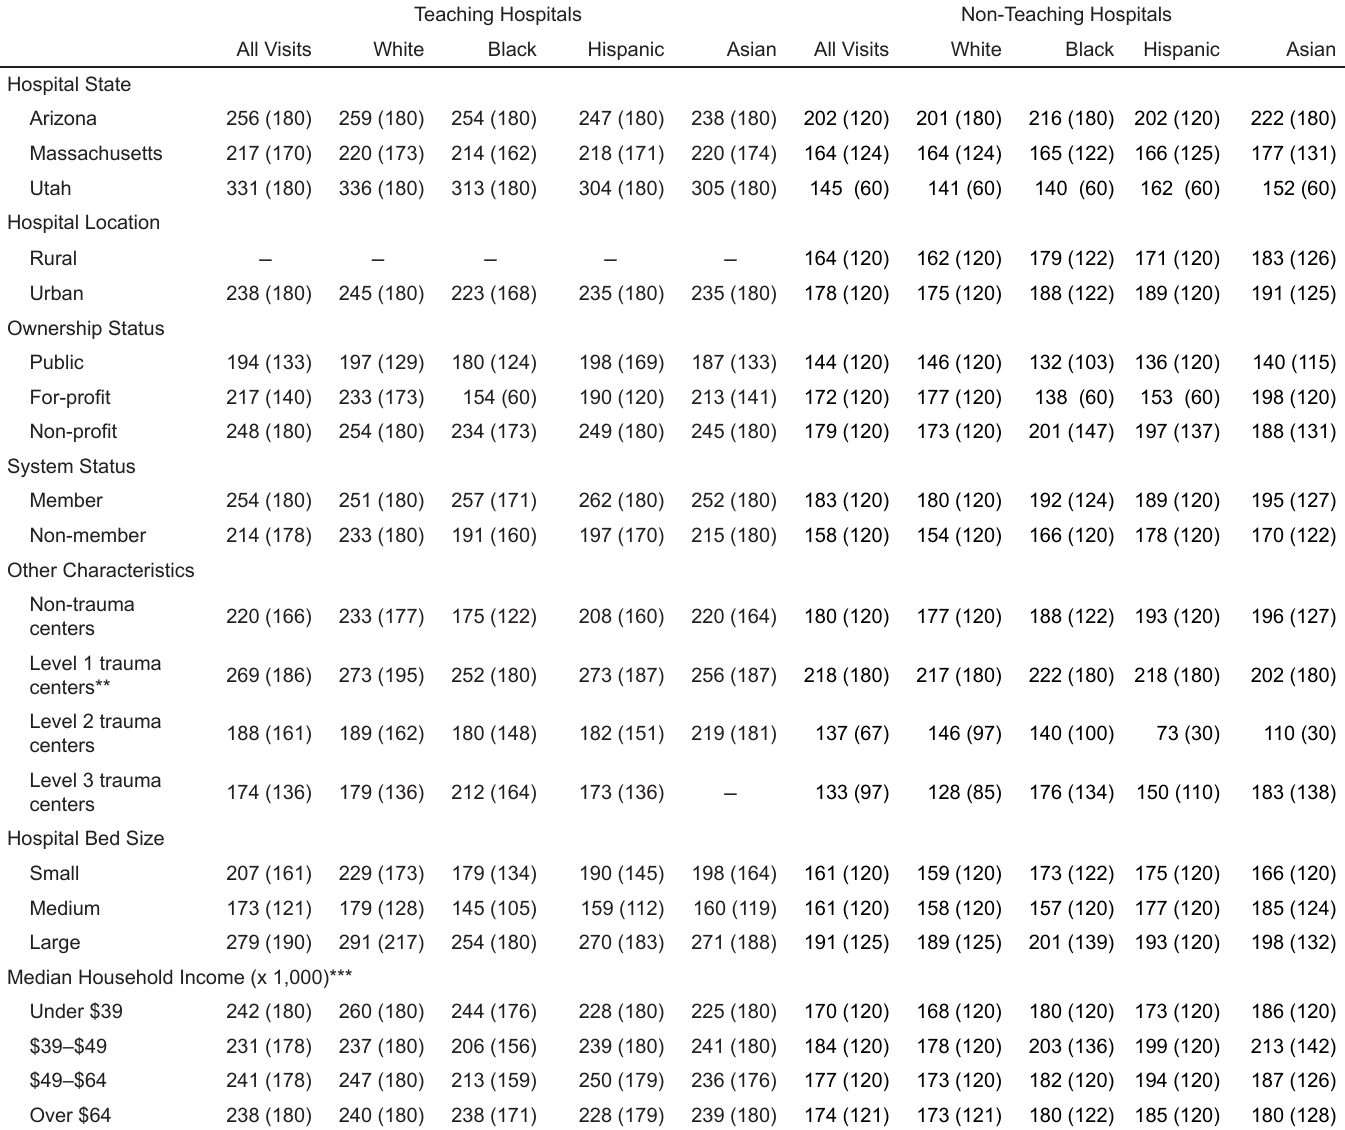
Table 2. Mean and median duration* of routine visits to hospital emergency departments by hospital and area